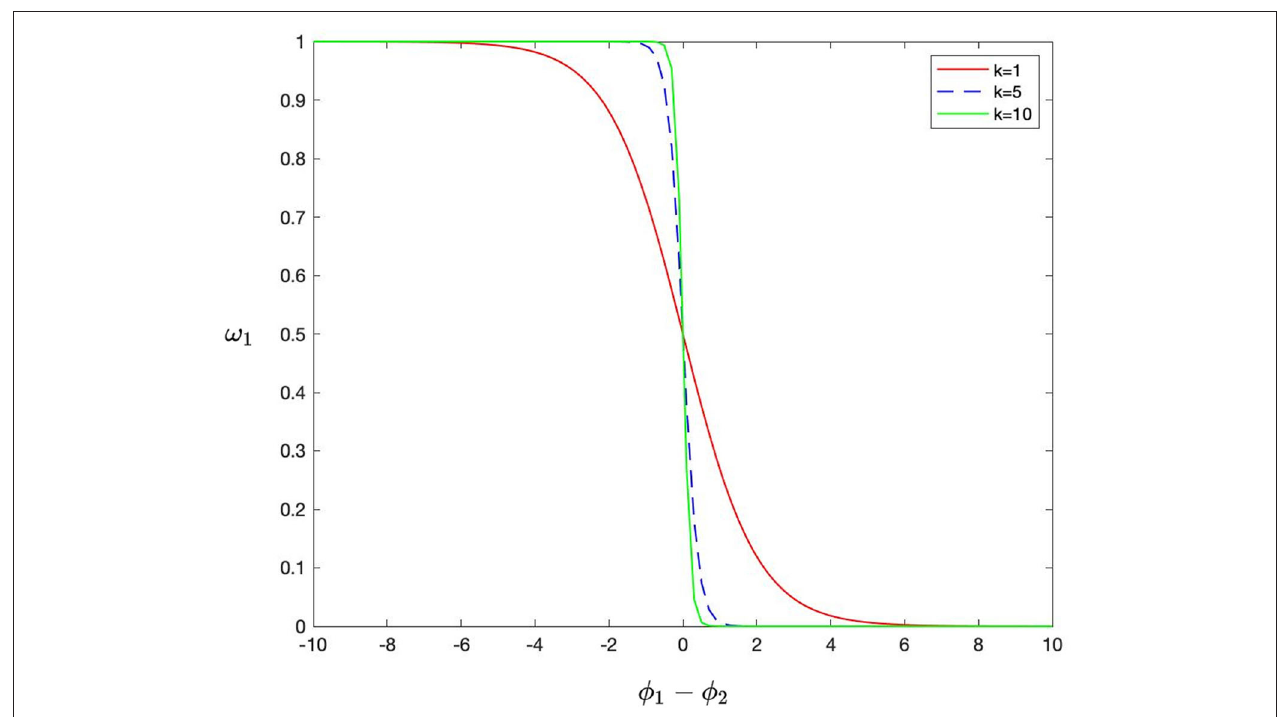
FIGURE 2 | The shape of the function of ω 1